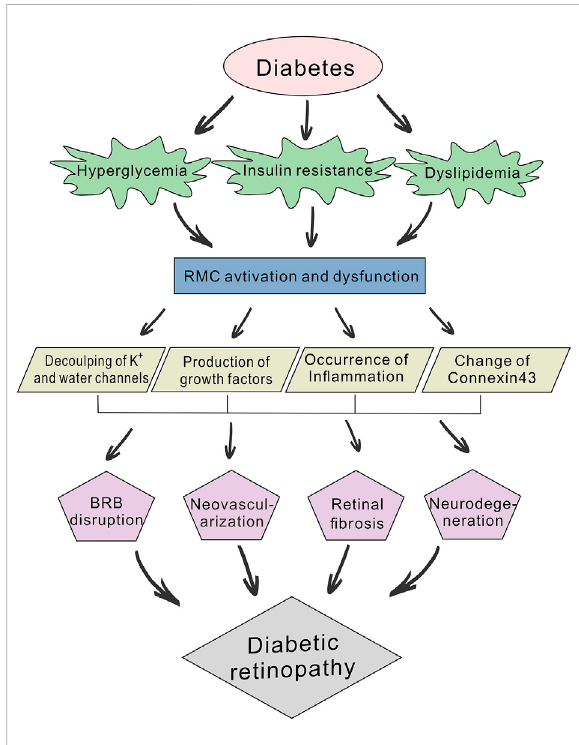
FIGURE 1 Schematic diagram of the pathogenic mechanisms of diabetic retinopathy (DR). Diabetes can lead to abnormal glucose and lipid metabolism, while hyperglycemia, insulin resistance and dyslipidemia will further accelerate the development of DR. Prolonged hyperglycemia induces the abnormal activation and dysfunction of retinal Müller cells (RMCs) and affects their physiological function. This involves the decoupling of potassium and water channels, production of growth factors (e.g., TGF- β , VEGF and FGF), occurrence of in fl ammation and changes in Connexin43 expression. RMC dysfunction also participates in blood-retinal barrier (BRB) disruption, neovascularization, retinal fi brosis, and